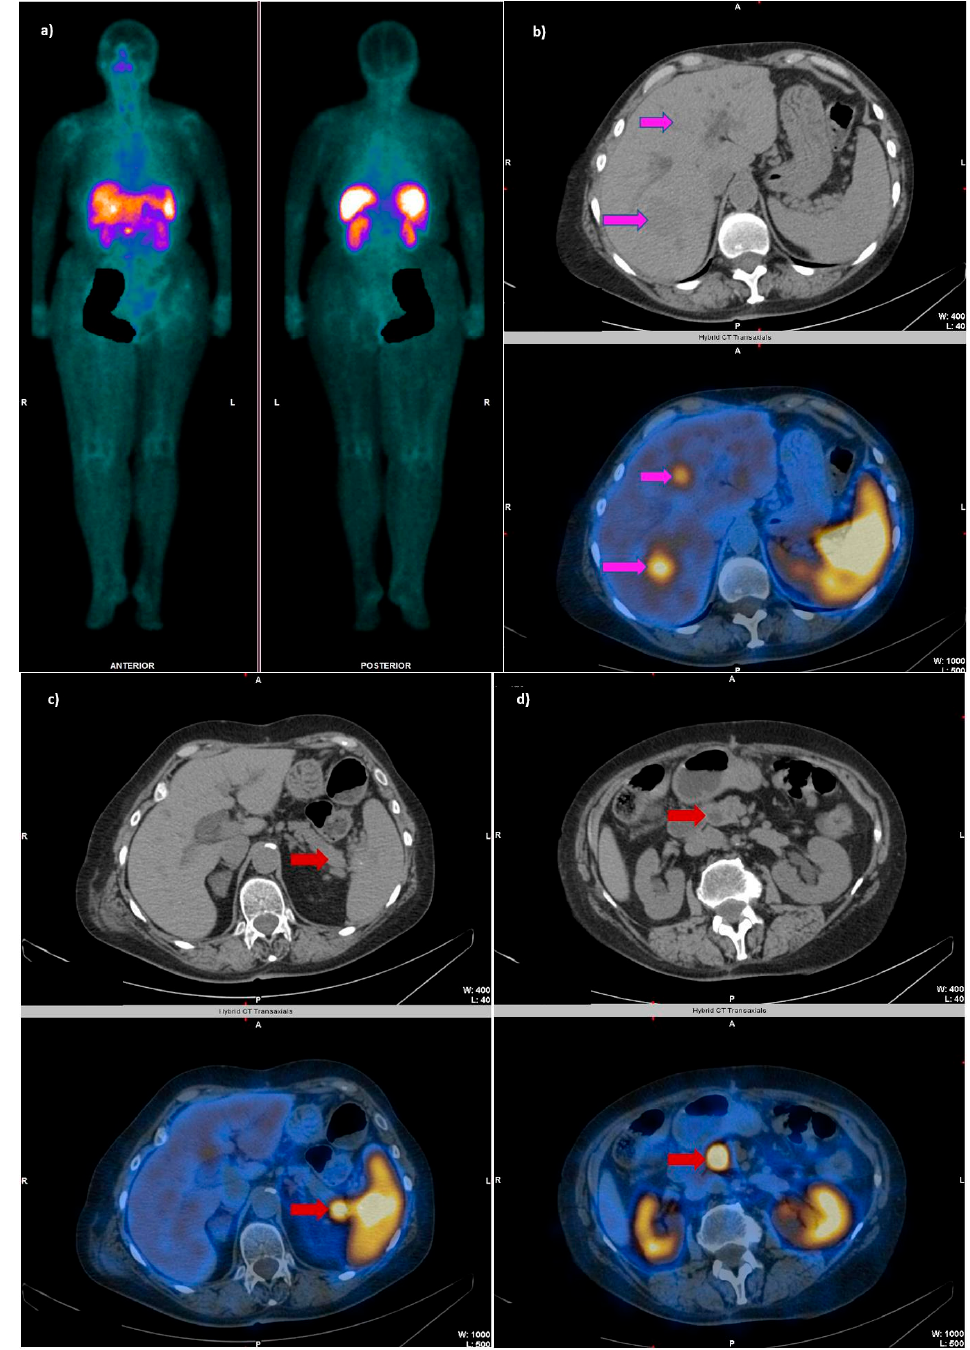
Figure 3. A 69-year-old female patient diagnosed with a pancreatic neuroendocrine tumor (confirmed through multiple biopsies from the pancreatic head and liver metastasis as NET G2), undergoing treatment with somatostatin analogs. The WB SRS revealed 99m Tc-EDDA/HYNIC-TOC uptake in the abdominal region ( a ), with the SPECT/CT showing SSTR-expressing liver metastases ( b ) and two foci of increased uptake in the pancreas: one corresponding to the tail of the pancreas ( c ) and one in the head of the pancreas ( d ).